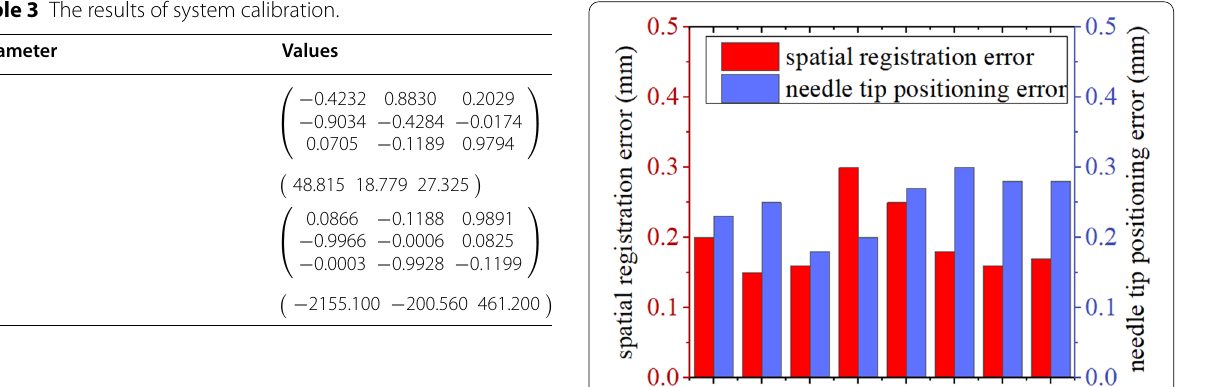
Figure 11a. Through 8 repeated tests, the final result is as